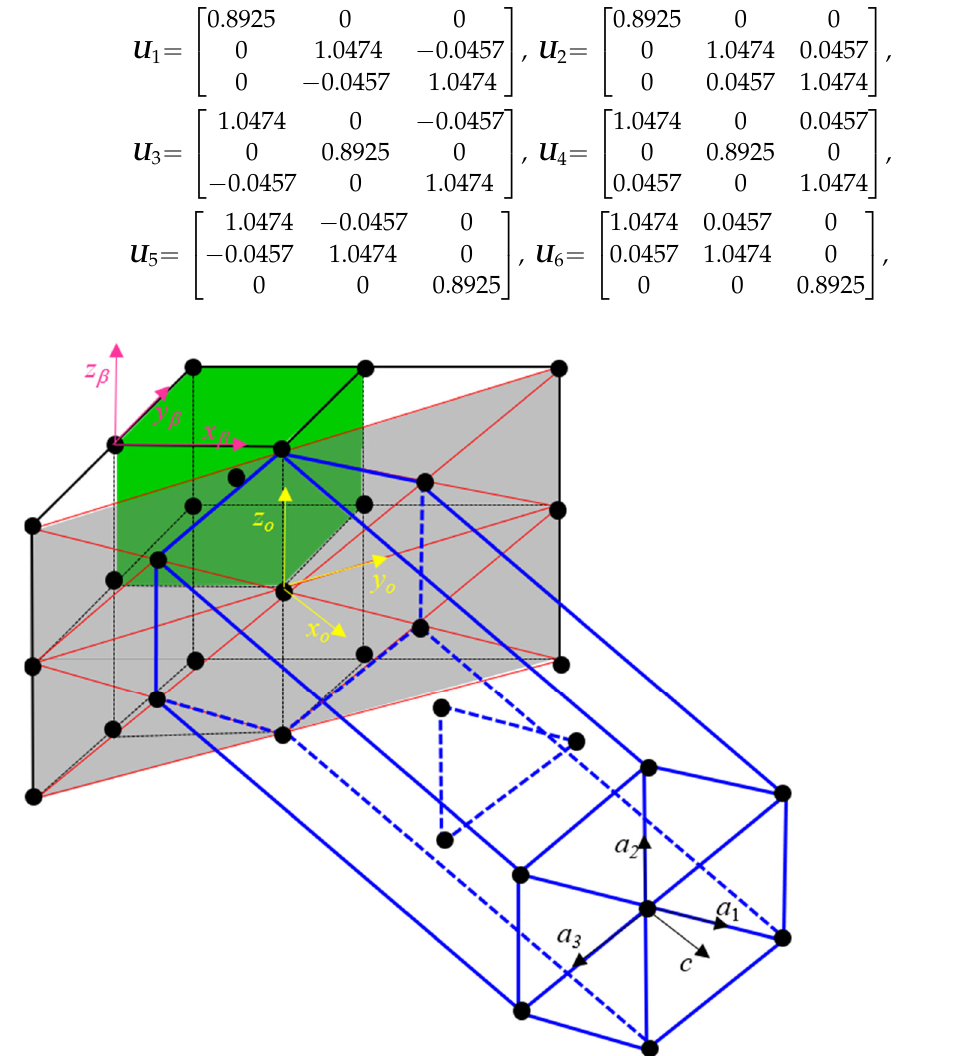
Figure 1. Crystal lattice of parent BCC and product HCP phase, and orthogonal lattice correspondence between BCC and HCP phase.